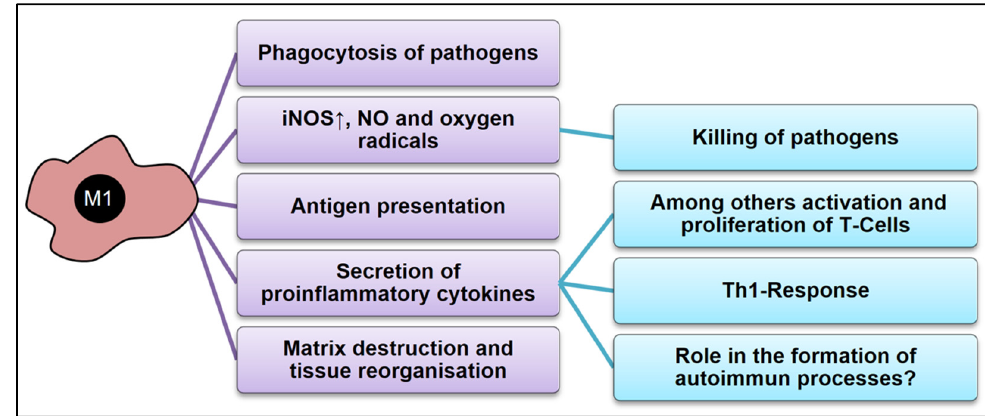
Figure 4. Summary of the basic functions of M1-Macrophages.